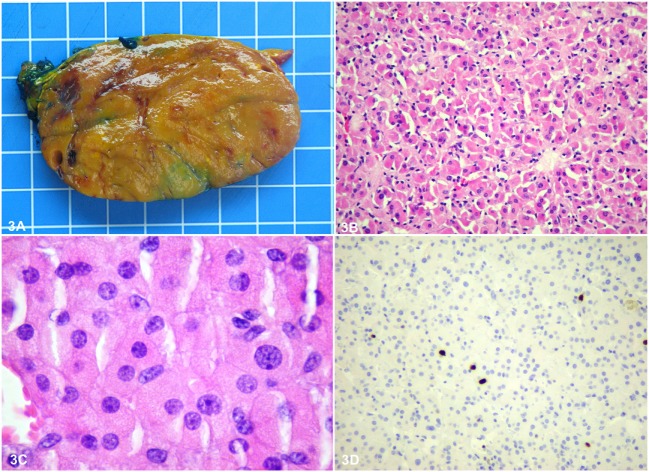
Macroscopically, the adrenal tumor was a rounded, well-circumscribed orange brown homogeneous mass, measuring 8.5 cm × 6 cm × 4.5 cm (A). The size of the grid in the background is 1 cm × 1 cm. Microscopically, it was well circumscribed and partially encapsulated and consisted entirely of bland looking oncocytic cells, with granular eosinophilic cytoplasm and round nuclei with prominent nucleoli, arranged in a solid pattern (B,C). Parenchymatous or venous invasion, high mitotic rate, and atypical mitoses were not observed. Therefore, according to the Lin–Weiss–Bisceglia criteria, it was diagnosed as a benign oncocytic adrenocortical adenoma. Further evaluation using immunohistochemistry revealed negative BRAF V600E immunostaining and a low Ki-67 proliferation index (<2%) (D).